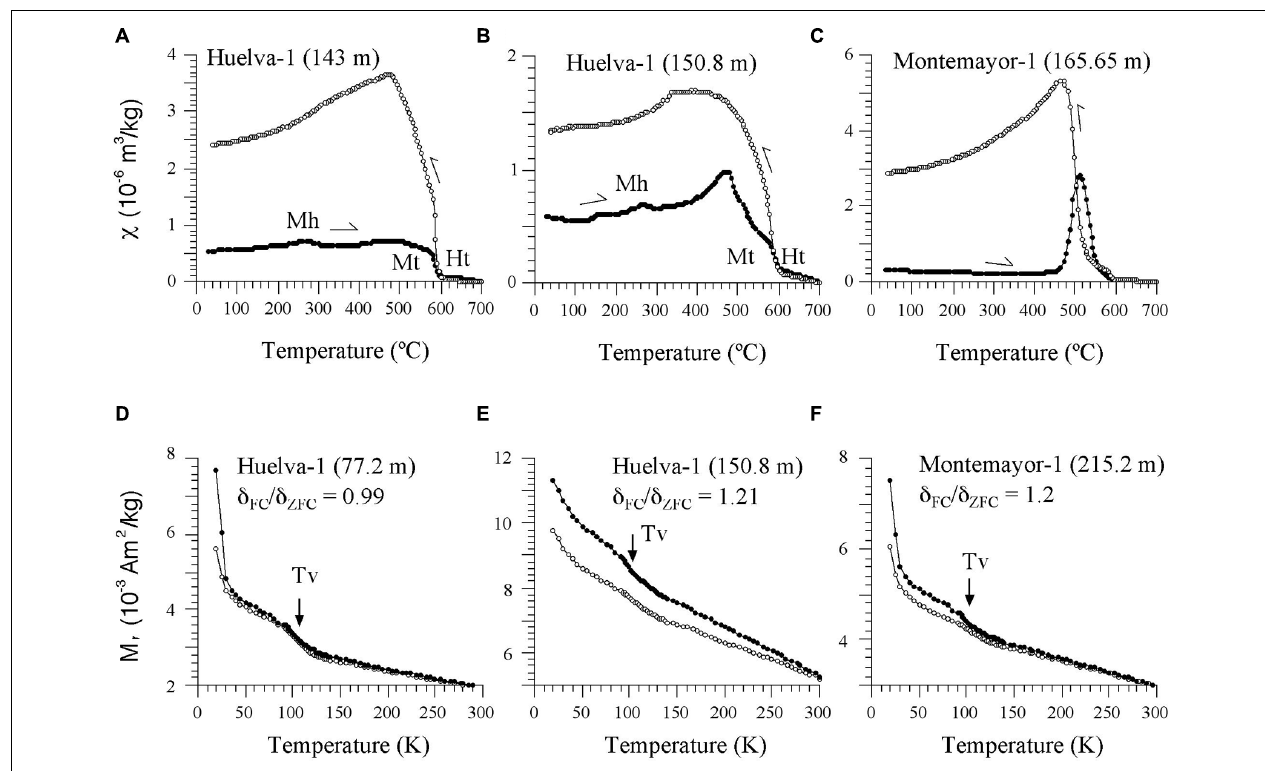
FIGURE 6 | (A–C) Representative χ –T curves for samples from the Huelva-1 and Montemayor-1 boreholes. Mt, magnetite; Ht, hematite; Mh, maghemite. (D–F) Representative low-T experiments for samples from the Huelva-1 and